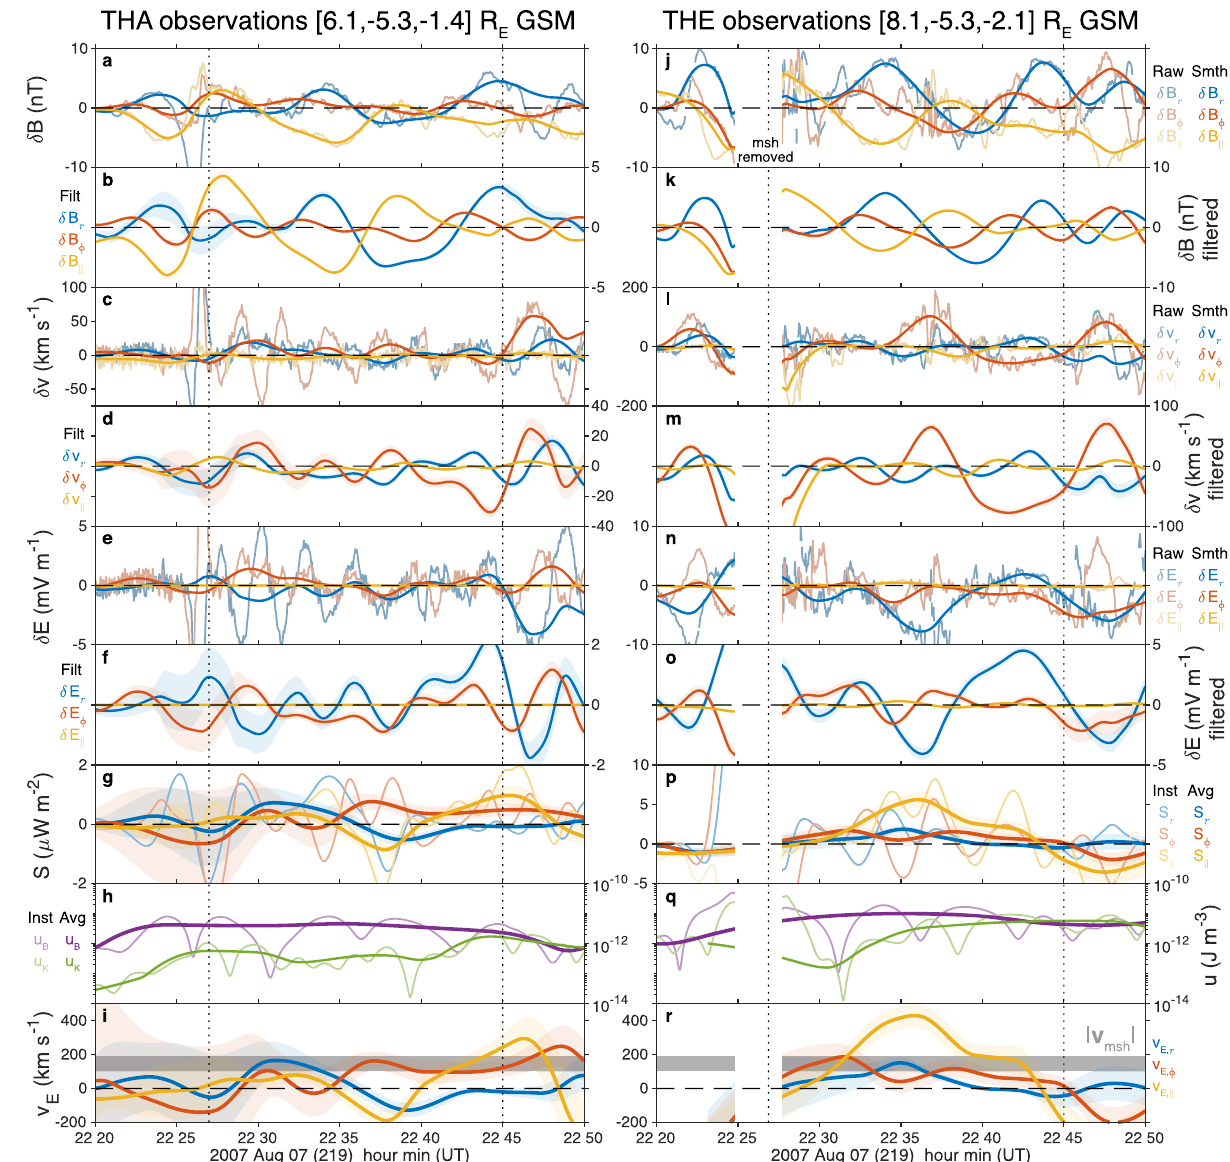
Fig. 1 THEMIS spacecraft time-series observations in the magnetosphere. Shown for THA ( a – i ) and THE ( j – r ). From top to bottom the fi rst set of panels show perturbations in the magnetic ( a , b , j , k ), ion velocity ( c , d , l , m ) and electric ( e , f , n , o ) fi elds. In these vertical pairs, top panels show the raw (thin) and LOESS smoothed (thick) data, whereas the bottom panels show the latter once detrended. Subsequent panels depict the Poynting vector ( g , p ) and energy density ( h , q ), showing instantaneous (thin) and time-averaged (thick) values. Finally, the energy velocity ( i , r ) is shown compared to the absolute magnetosheath fl ow speed at THB (grey). Throughout, standard errors are indicated by shaded areas. Vertical dotted lines demark the times of little upstream pressure variations following the isolated impulsive jet that triggered this